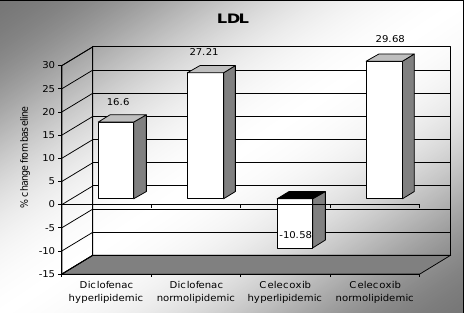
Figure (4) : -The % changes in serum LDL- cholesterol concentration from baseline value after 8weeks treatment with diclofenac or celecoxibin hyperlipidemic and normolipidemic type 2 diabetic